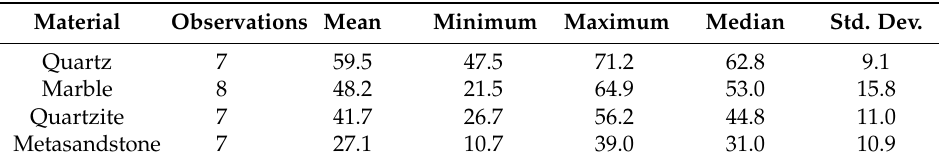
Table 4. The statistical results of E t (GPa).